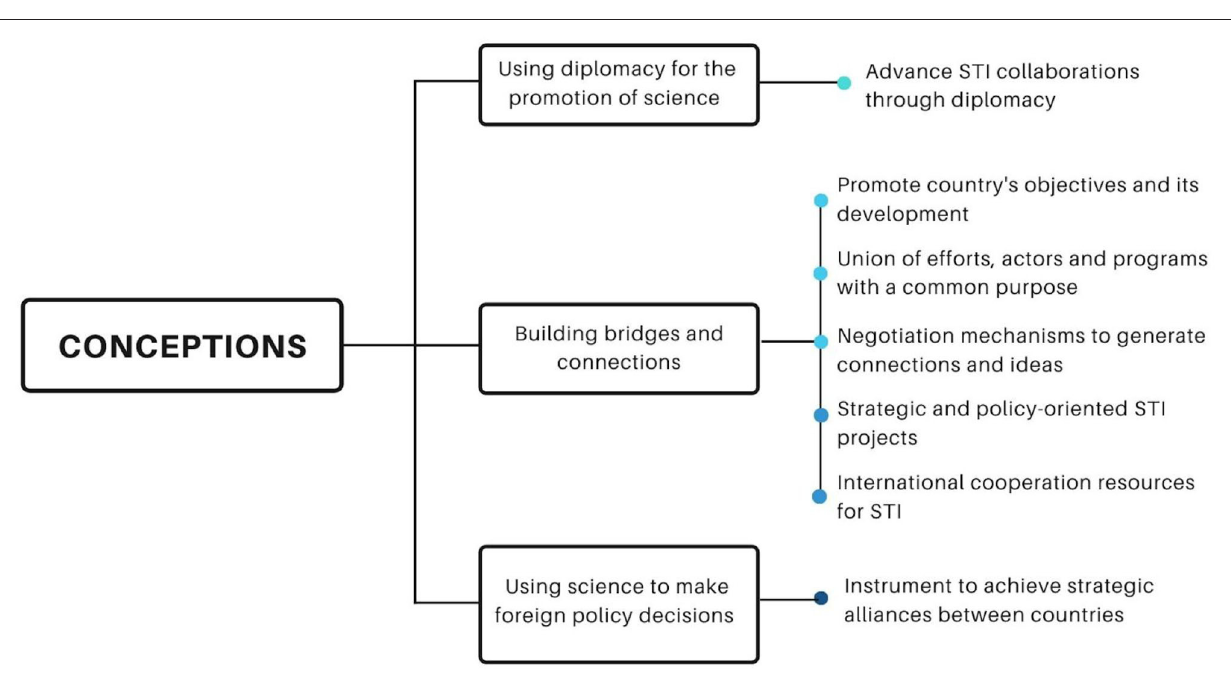
maintain a good relationship with our neighbors,